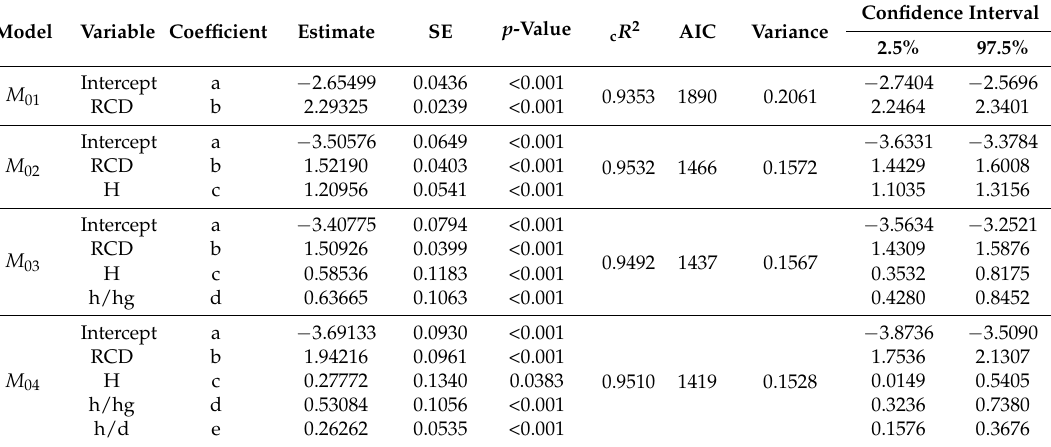
Table 5. Comparison among the top four candidate models.